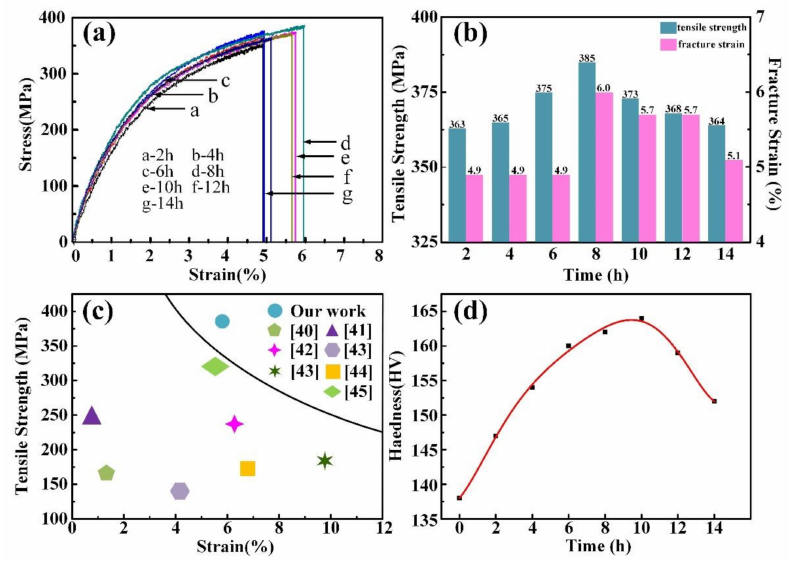
Figure 7. The mechanical properties and hardness of Al-13Si-5Cu-2Ni alloy solid solution treated at 510 ◦ C for 8 h and 165 ◦ C aging for different hours: ( a ) the engineering stress–strain curves, ( b ) bar graph of tensile strength and fracture strain, ( c ) hardness of aging different hours, and ( d ) contrast diagram of different strengthening methods for Al alloys with this